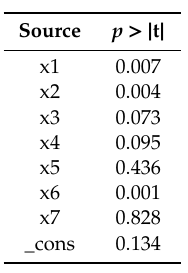
Table 3. The regression output p -value of each